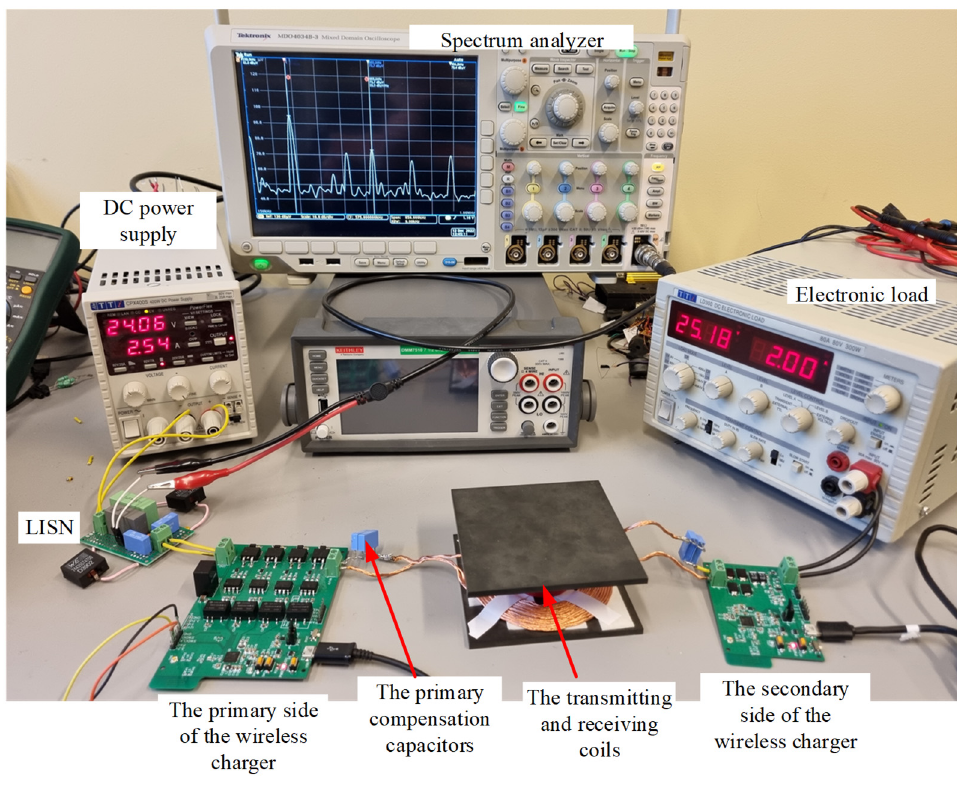
Figure 2. An image of the experimental prototype connected to the measuring equipment.